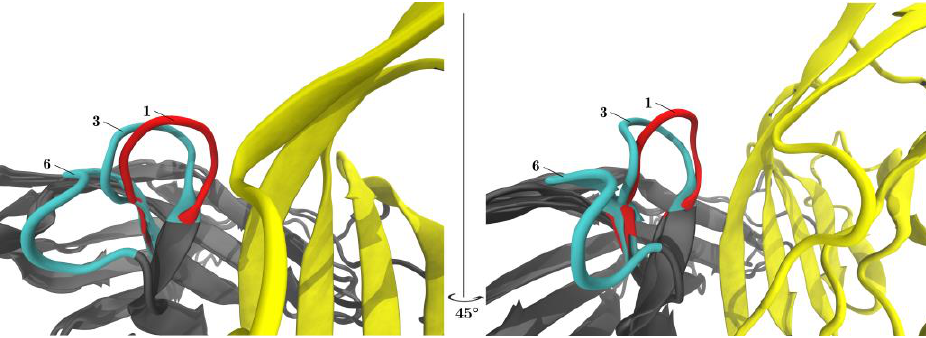
Figure 6. PD-L1 shifts the equilibrium of the CC’-loop towards the ‘closed’ conformation. The left and the right panel show the same content but rotated 45°. Superposition of the central structures of clusters 1, 3, (both members of meta-cluster ‘closed’) and 6 (meta-cluster ‘open’) are displayed with VMD. When PD-L1 binds to PD-1 (red) the CC’-loop is locked in the so-called ‘closed’ conformation (1) turned 90° towards PD-L1 (yellow). In the PD-1 Apo (cyan) the CC’-loop exhibits both the ‘open’ (6) and ‘closed’ conformation (3).